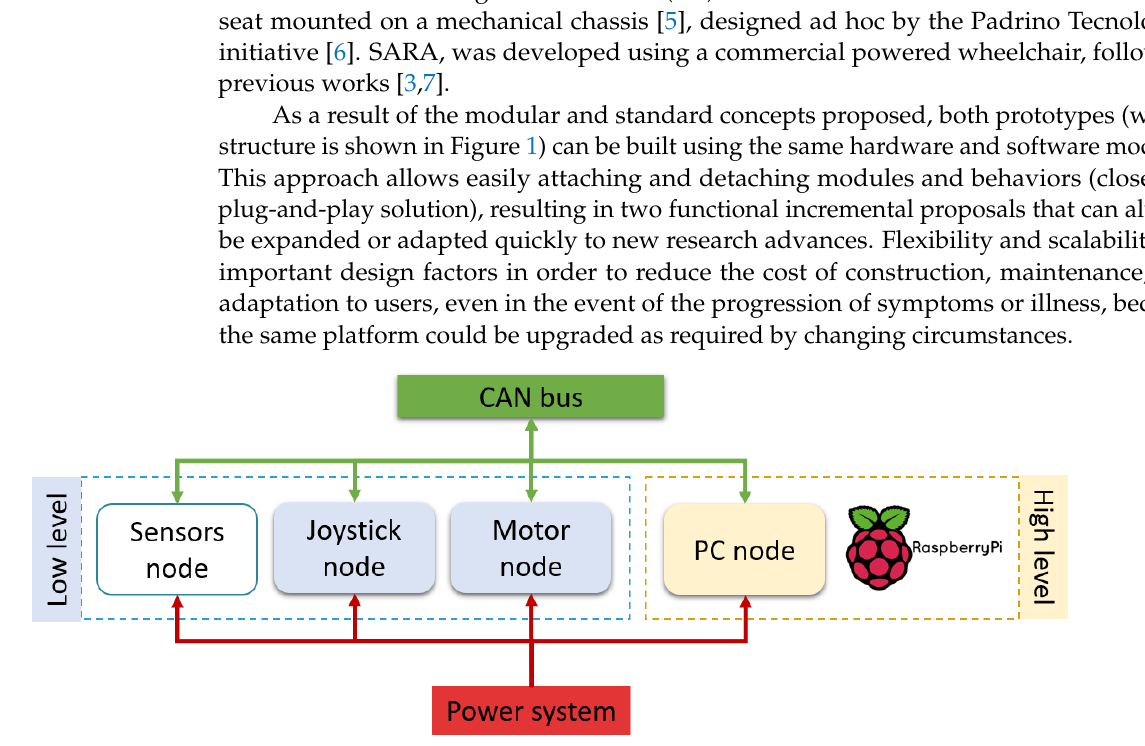
Figure 1. Simplified diagram of the nodal structure of the intelligent wheelchair